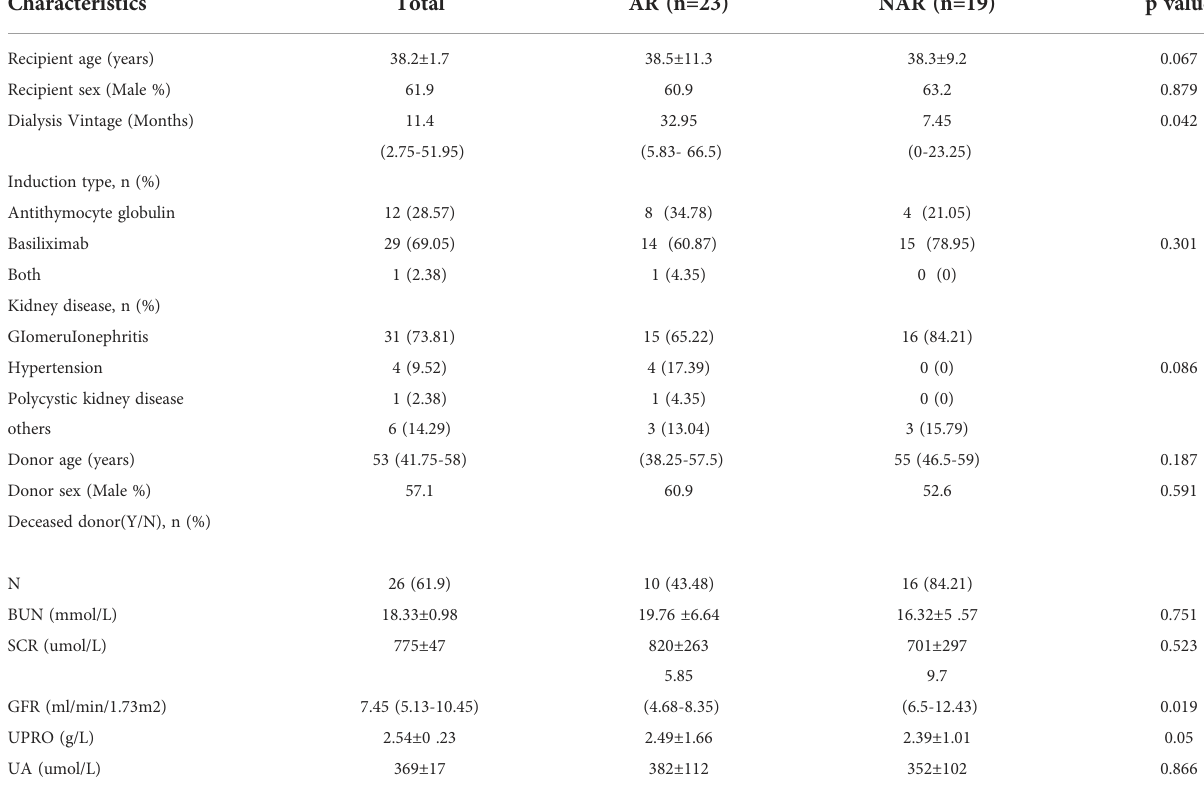
TABLE 1 Demographic and clinical characteristics of kidney allograft